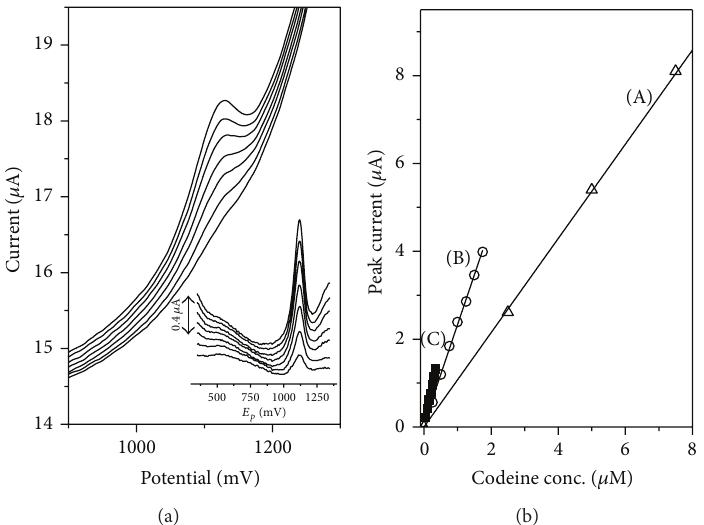
Figure 8: (a) The DP SV codeine calibration voltammograms for 0.05, 0.1, 0.15, 0.2, 0.25, 0.3, and 0.35 𝜇 M codeine obtained for preconcentration time 120 s in 0.1M phosphate buffer (pH of base electrolyte 3.0) and volume of Nafion/MWCNTs 10 𝜇 L and (b) codeine calibration curves obtained for preconcentration times of (A) 15, (B) 60, and (C) 120s. All other conditions are as in Figure 5.